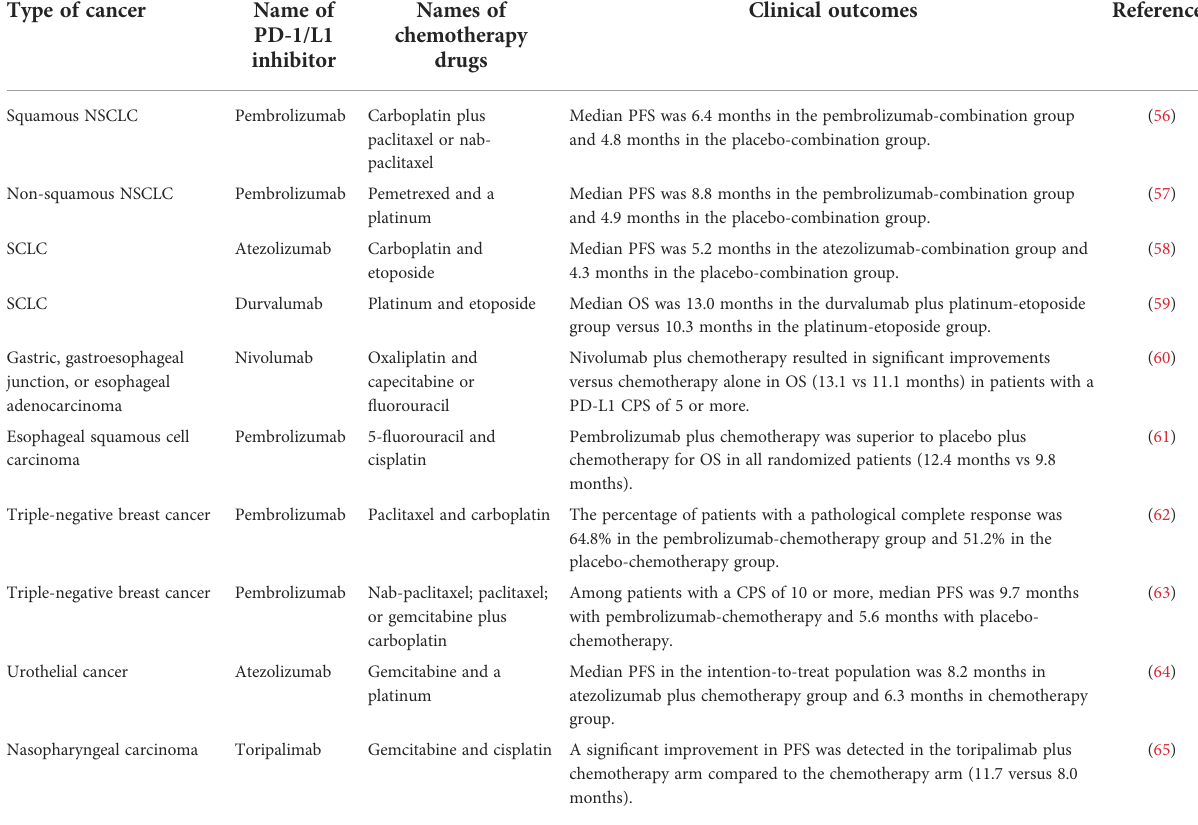
TABLE 1 Partial phase 3 clinical trials of PD-1/L1 inhibitor plus chemotherapy in different